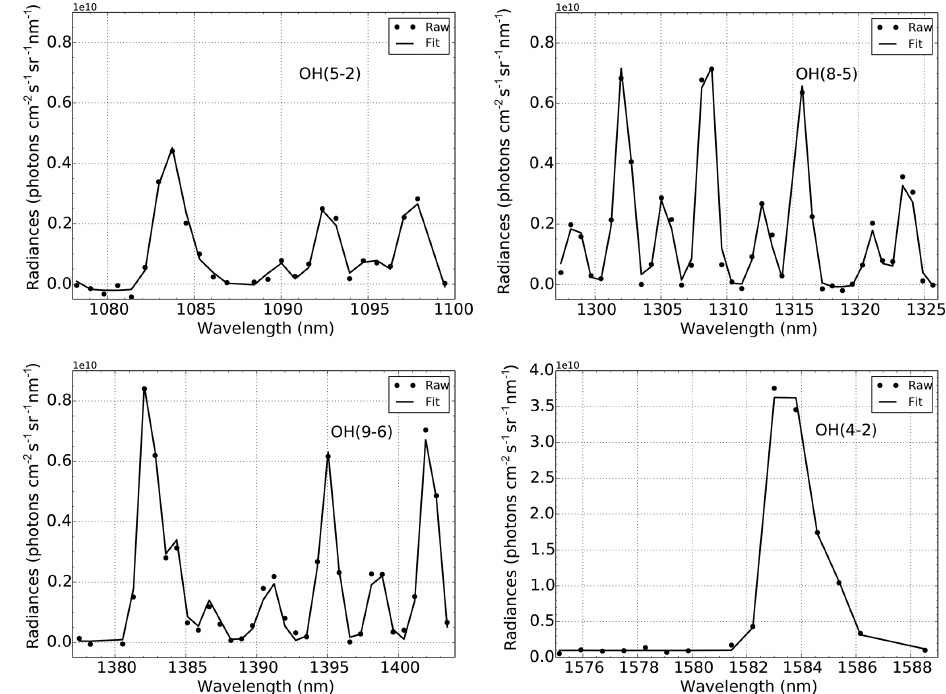
Figure 2. Monthly zonal median OH(4-2), OH(5-2), OH(8-5), and OH(9-6) limb spectra at tangent altitude about 86km for September 2005 in a latitude range 35–40 ◦ N. raw: the raw limb spectra measured by SCIAMACHY; fit: simulated limb spectra as measured by SCIAMACHY from retrieval